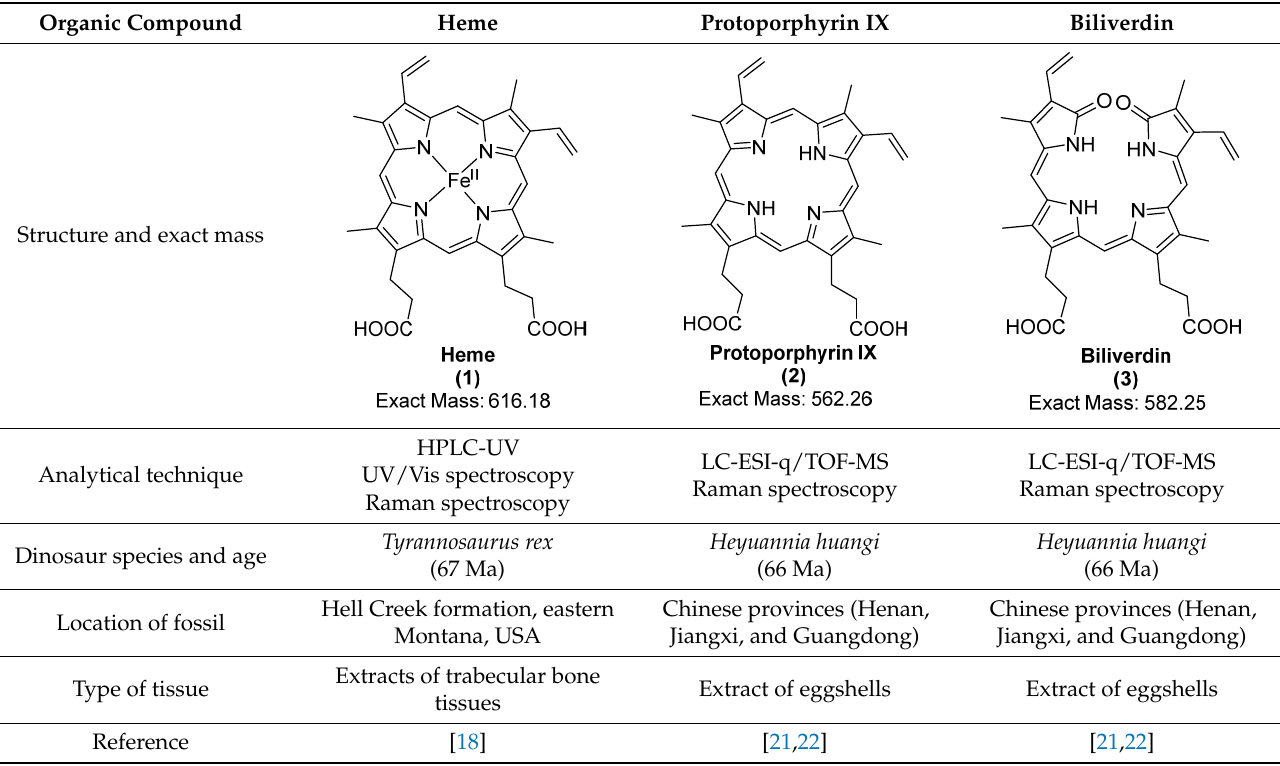
Table 1. Porphyrins detected in dinosaurs.